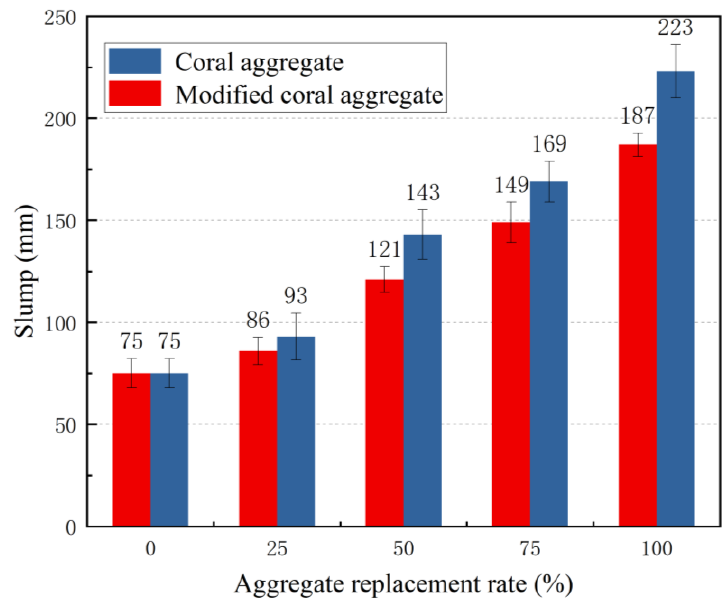
Figure 10. Relationship between aggregate replacement rate and